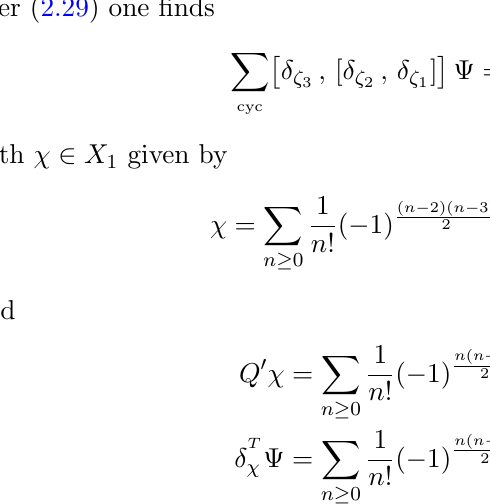
Table 2 . Products that can be read from kinematic and dynamical equations in a (cid:12)eld theory. over (2.29) one